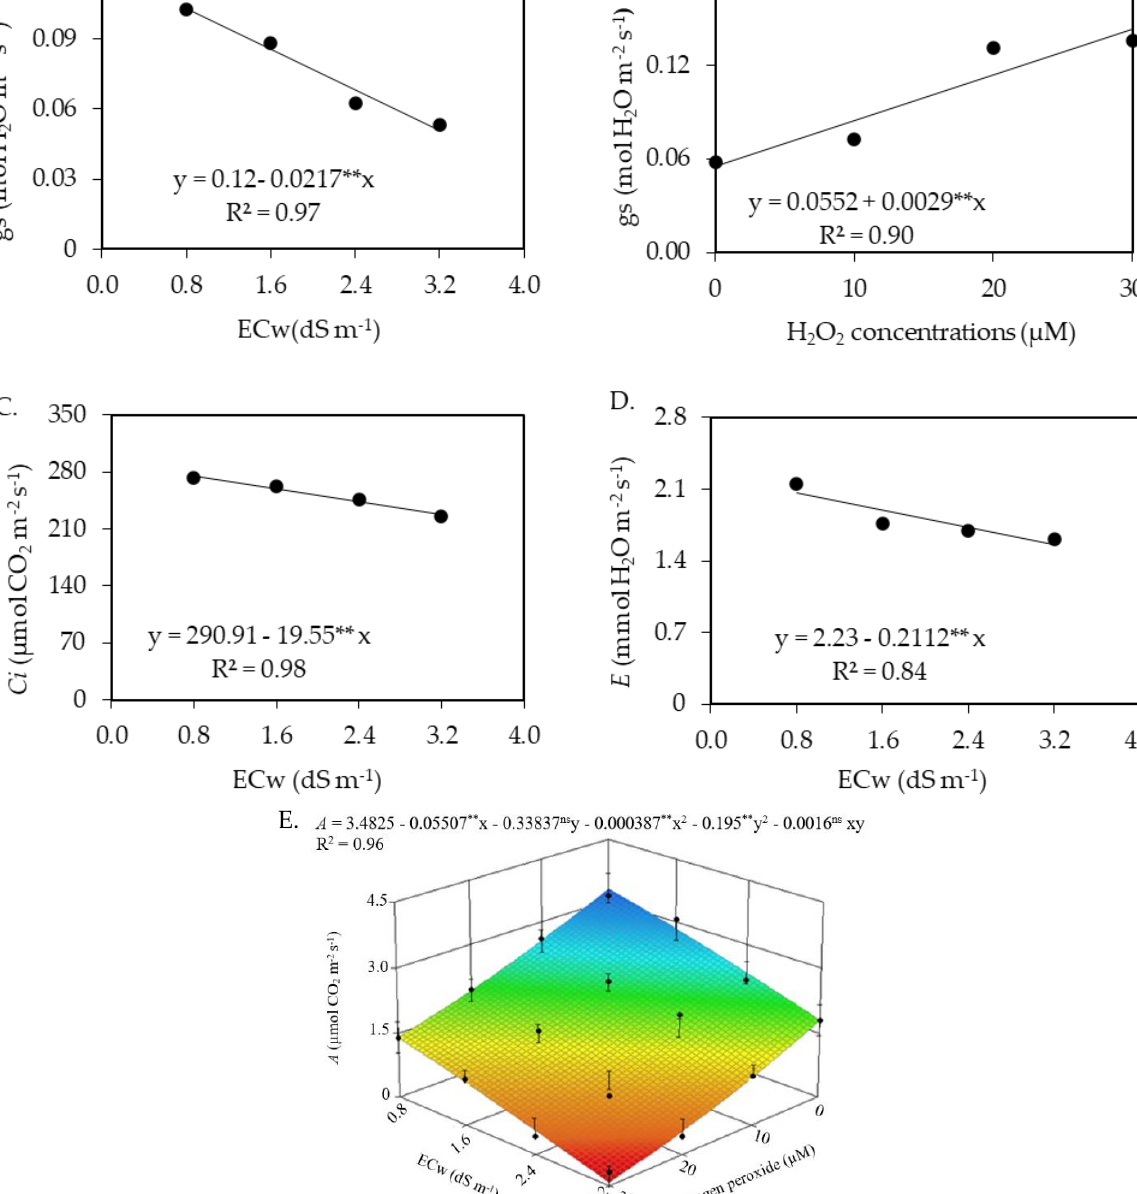
Figure 1. Stomatal conductance ( gs ) of soursop plants cv. Morada Nova as a function of the salinity of irrigation water (ECw) ( A ) and concentrations of hydrogen peroxide (H 2 O 2 ) ( B ), internal CO 2 concentration ( Ci ) ( C ), and transpiration ( E ) ( D ) as a function of ECw and CO 2 assimilation rate ( A ) ( E ) as a function of the interaction between ECw levels and H 2 O 2 at 210 days after transplantation. ** is, significant at p ≤ 0.01 by the F-test. x and y correspond to ECw and hydrogen peroxide (H 2 O 2 ) concentrations, respectively.